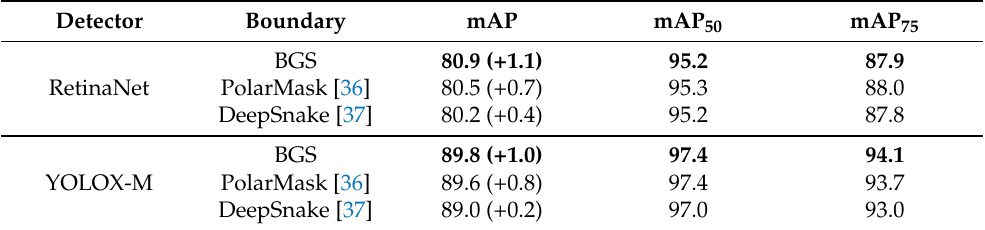
Table 8. Comparison results on SCD among three types of boundary prediction manners. ResNet-50 was used as the backbone for RetinaNet with the image scale of [600, 1000]. YOLOX employed the default image size ([640, 640]).